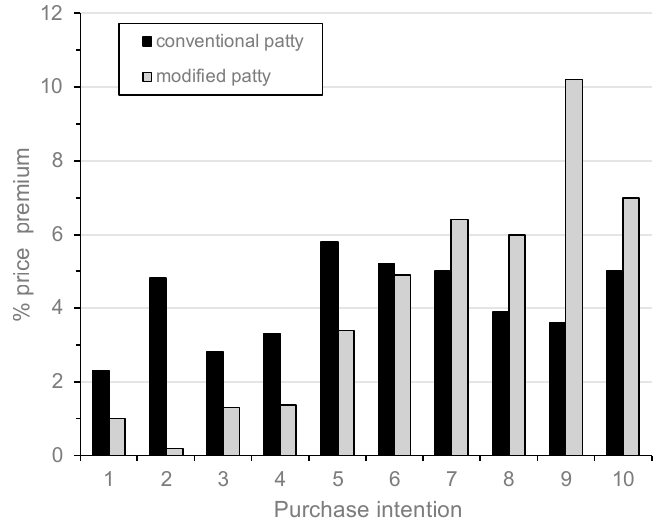
Figure 4. Relationship between willingness to pay (WTP) and purchase intention. Purchase intention (scale 1–10) where 1 = definitely would not pay, 10 = definitely would buy. Percentage price premium for the beef patties enriched with n -3 PUFA and vitamin D 3 .